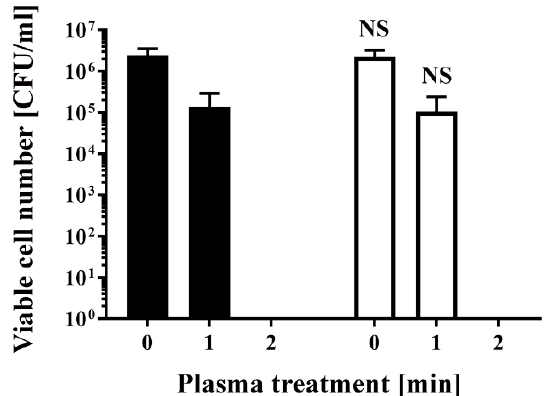
Figure 2. Treatment with a DBD plasma torch reduced the viable cell number of Escherichia coli transformed with a plasmid conferring ampicillin resistance, which was selected by spreading on ampicillin-containing agar medium and proliferated in ampicillin-containing liquid medium ( ■ ) by a similar amount as plasmid-transformed E. coli proliferated in ampicillin-free liquid medium ( □ ). A suspension of E. coli transformed with an ampicillin resistance gene-containing plasmid pPRO-EX-HT-CAT, selected in ampicillin-containing agar medium, and proliferated either in ampicillin-containing liquid medium ( ■ ) or ampicillin-free liquid medium ( □ ) was exposed to a DBD plasma torch for the indicated time (min). Viable cell count (colony forming units (CFU)/mL) was then determined before and after treatment. NS means no significant difference between ■ and □ at each time when verified by the non-repeated measured ANOVA (analysis of variance) followed by the Bonferroni correction. ANOVA for non-repeated measures was used for comparing the intragroup, while the Bonferroni correction was used as post-hoc analysis.